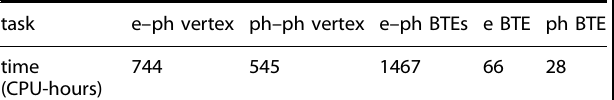
Table 1. Breakdown of the computational time needed for the various expensive parts of the code for silicon. An n -type carrier concentration of 2.75 × 10 14 cm − 3 at 300 K using a (50, 150) mesh set is considered